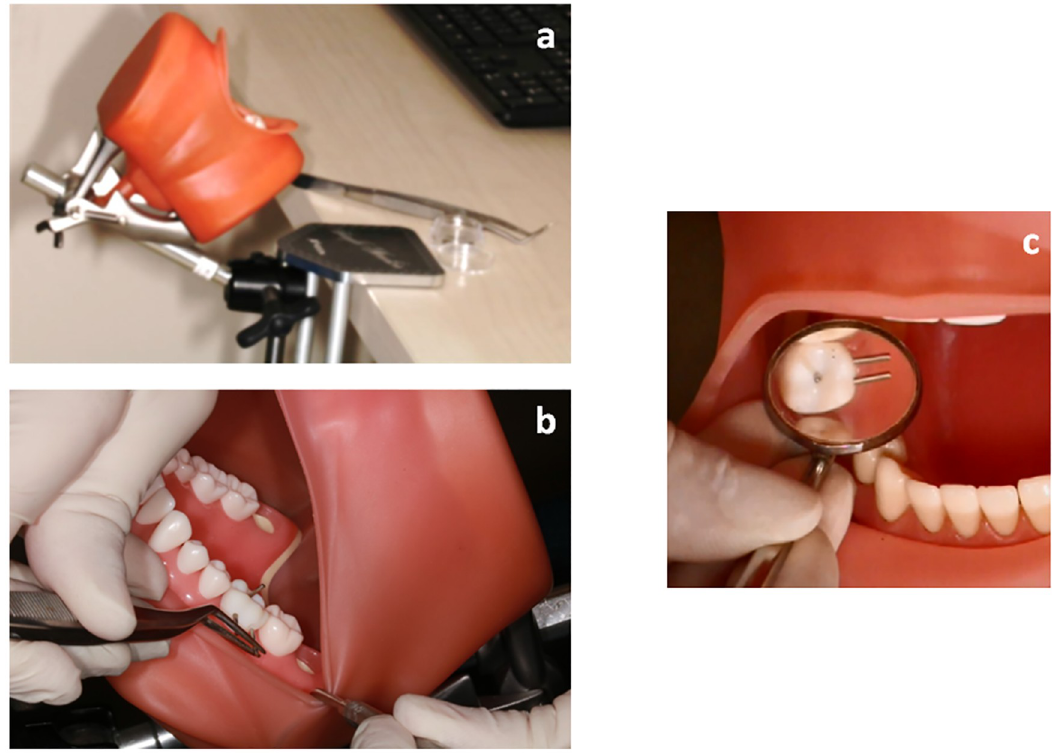
Fig 1. The PhantHome—Novel portable tool. (a) The tool is attached to a desk. (b) (c) "Intra-oral" view of the teeth with inserted pins.